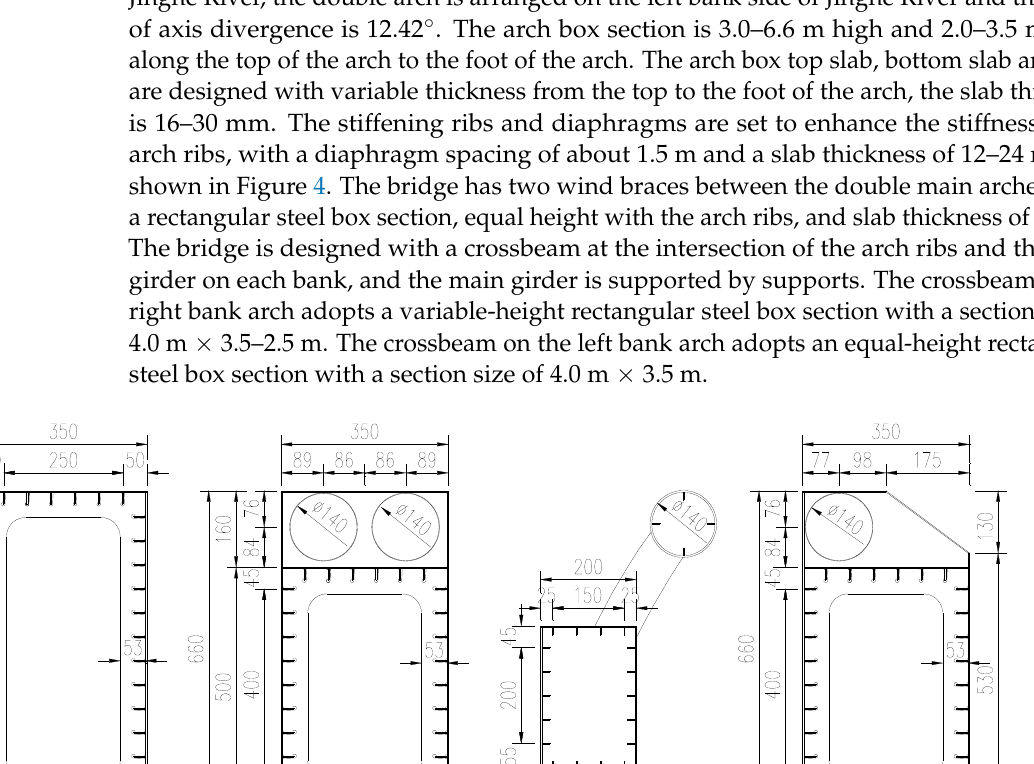
Figure 3. General layout of the main and secondary arch collaborative Y-shaped steel box arch bridge (unit: m).